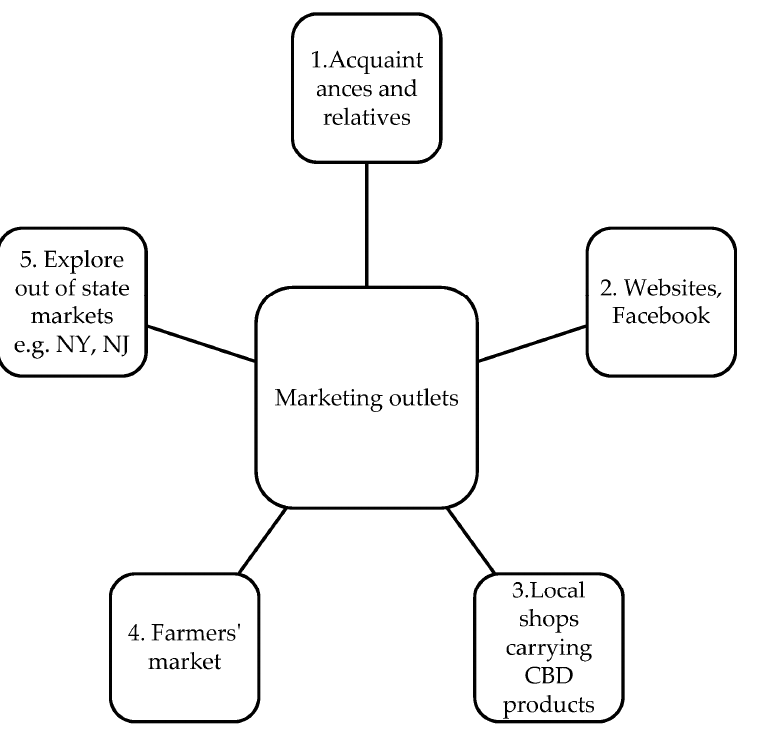
Figure 7. Marketing outlets for hemp products.